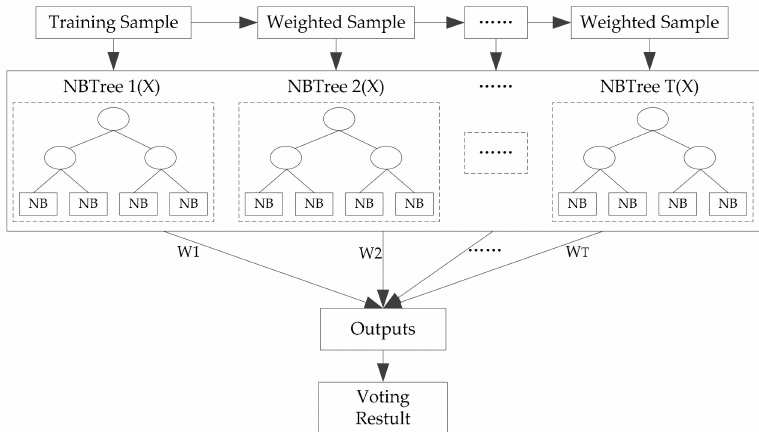
Figure 5. Flowchart of AdaBoost with naïve Bayesian